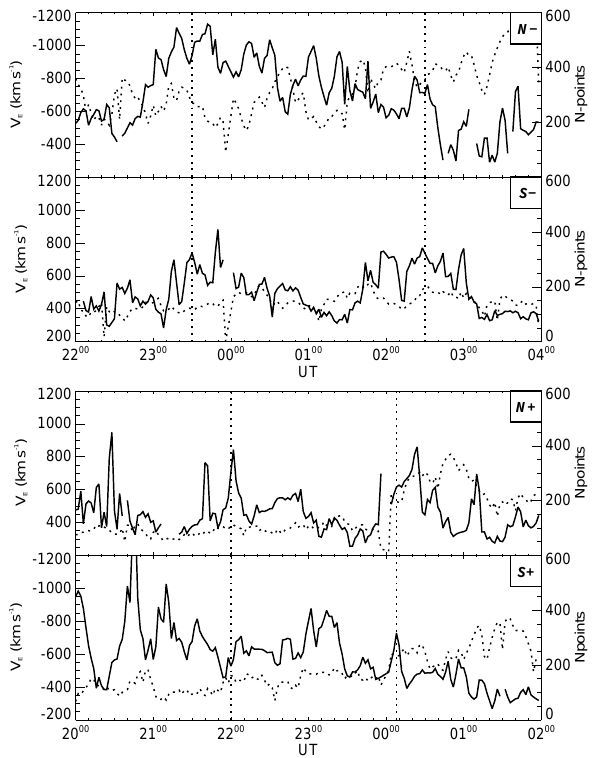
Fig. 4. Flow measurement time-series obtained from the Super- DARN radar observations and the “Map Potential” algorithm. The solid lines show the peak east-west ionospheric flow speed from the midnight sector (left hand axis) and the dotted lines show the num- ber of radar data points in the Map Potential fit (right hand axis). The icons in the top right-hand corner of each panel indicate the hemisphere (N/S) and the Interval (+/–). The vertical lines are the same as those in Fig.